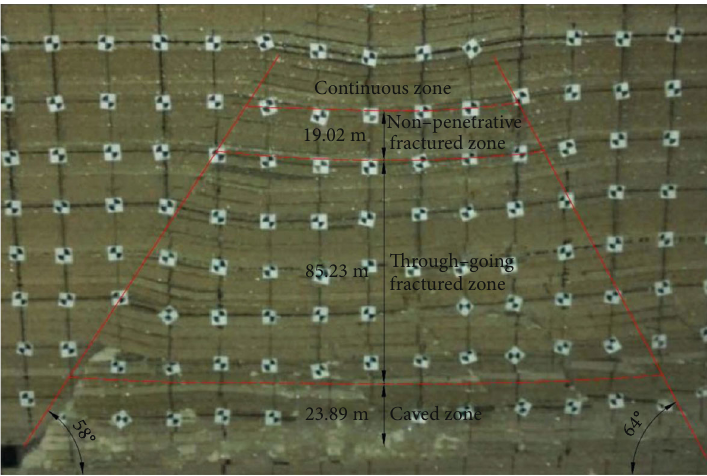
Figure 5: The characteristics of overburden failure on the model.